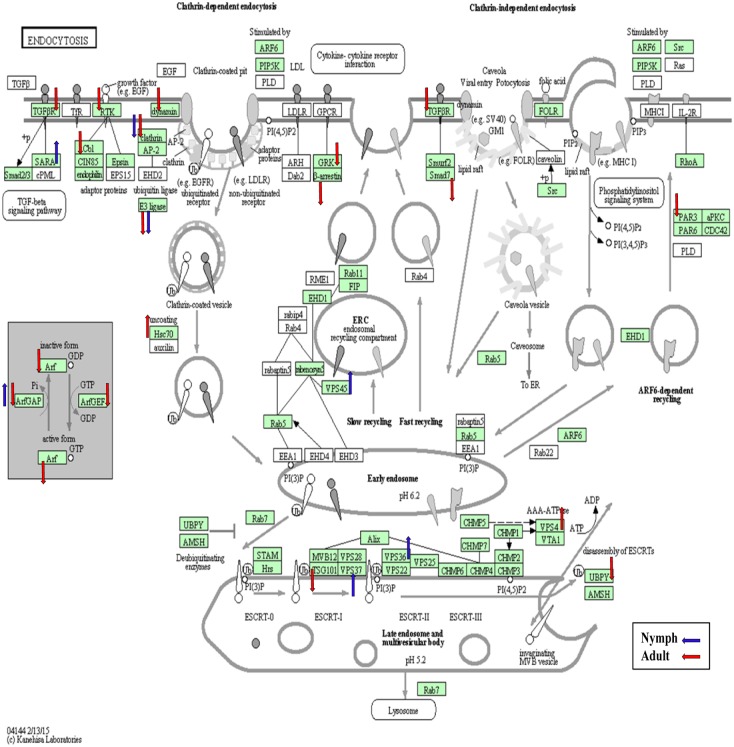
The Endocytosis KEGG pathway diagram showing the contigs that were differentially expressed (p<0.05) in nymphs (blue arrows) and adults (red arrows) in response to CLas infection.Of the assigned contigs (shaded in green), 22 were differentially expressed either in the nymphs or adults.